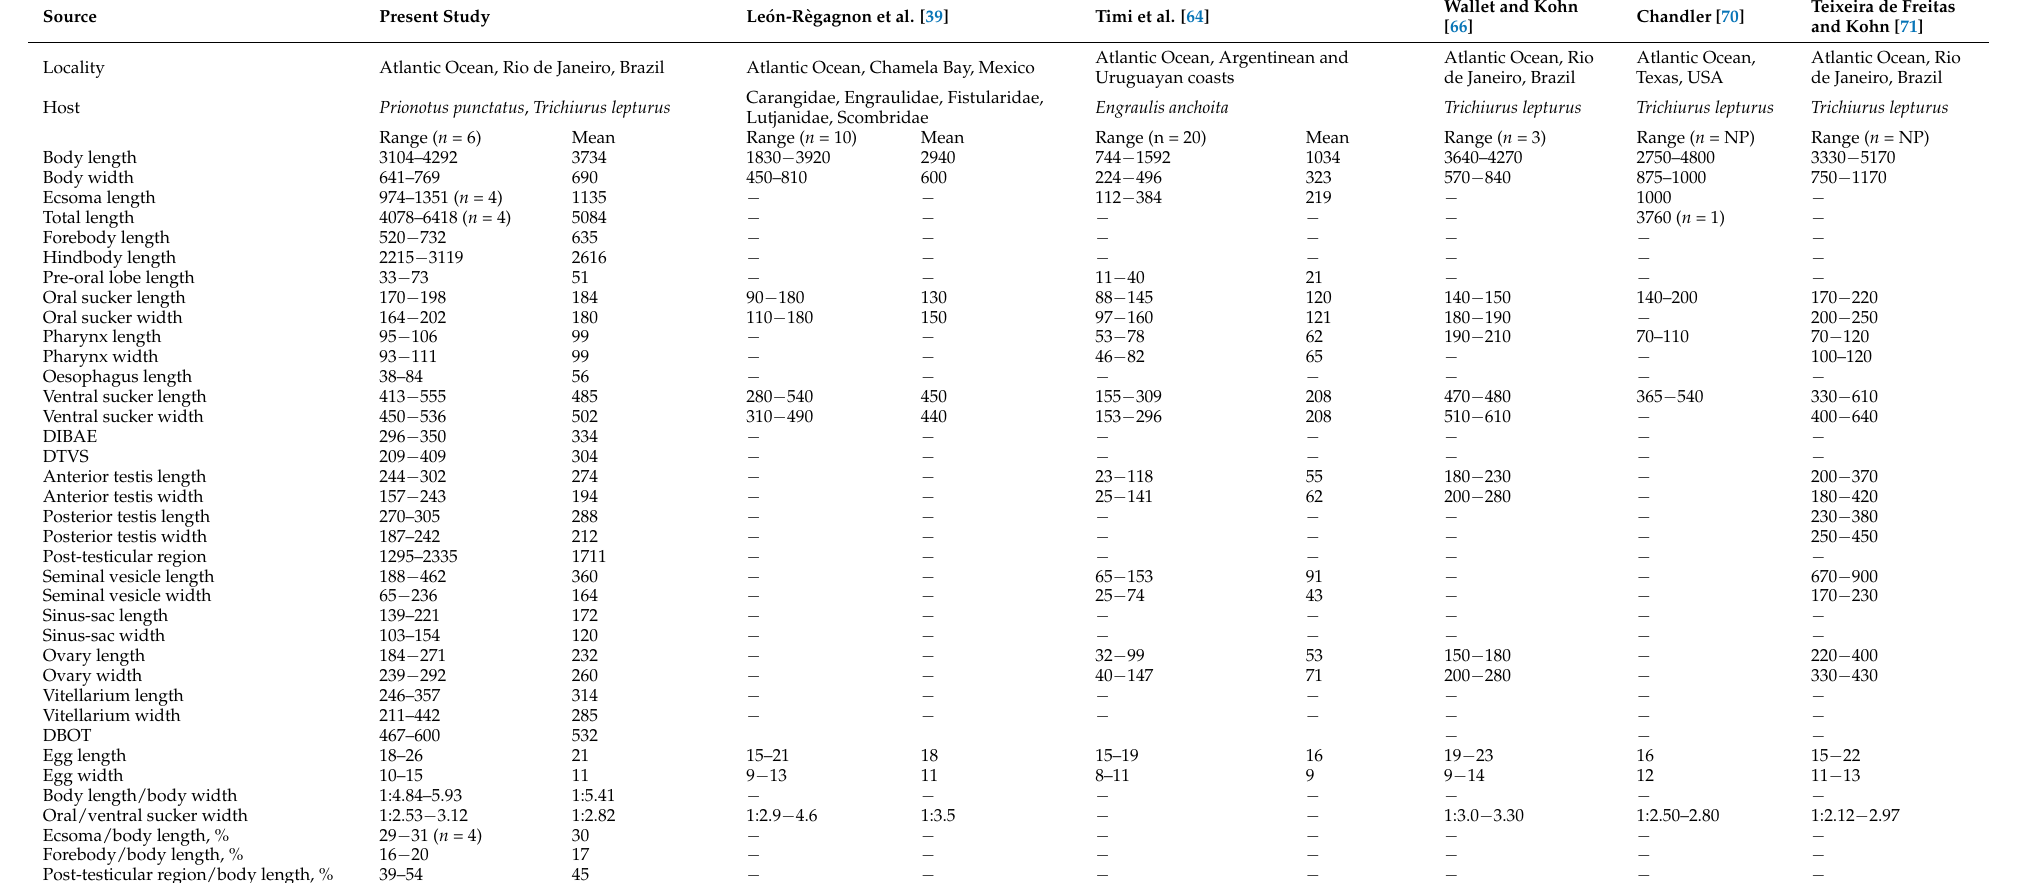
Table 4. Comparative metrical data of Lecithochirium microstomum Chandler,